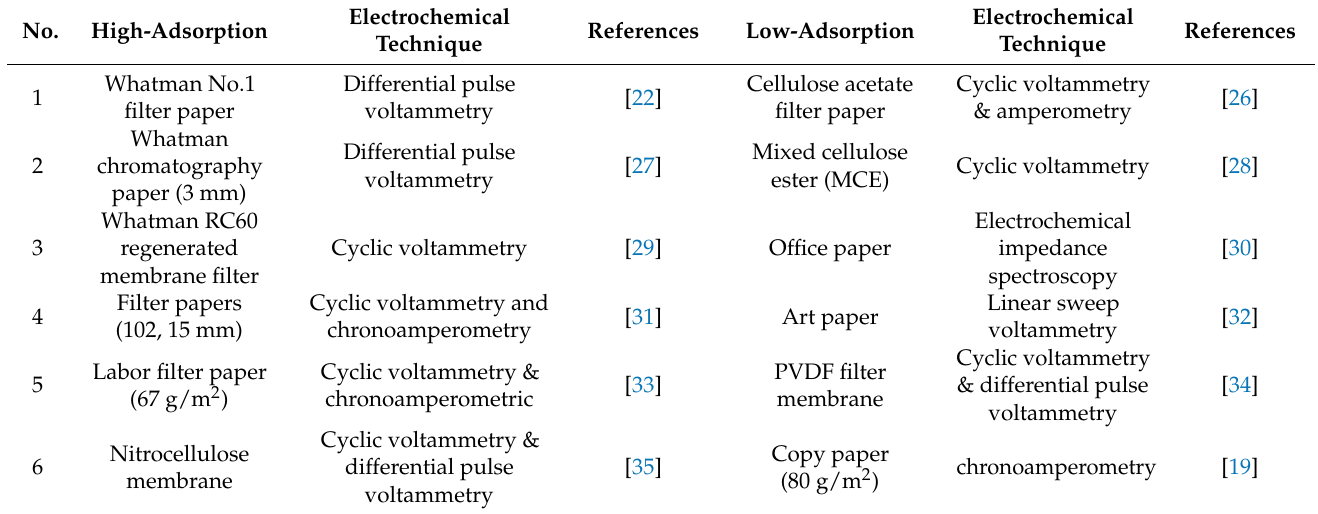
Table 1. Types of paper used as substrates for several paper-based electrochemical